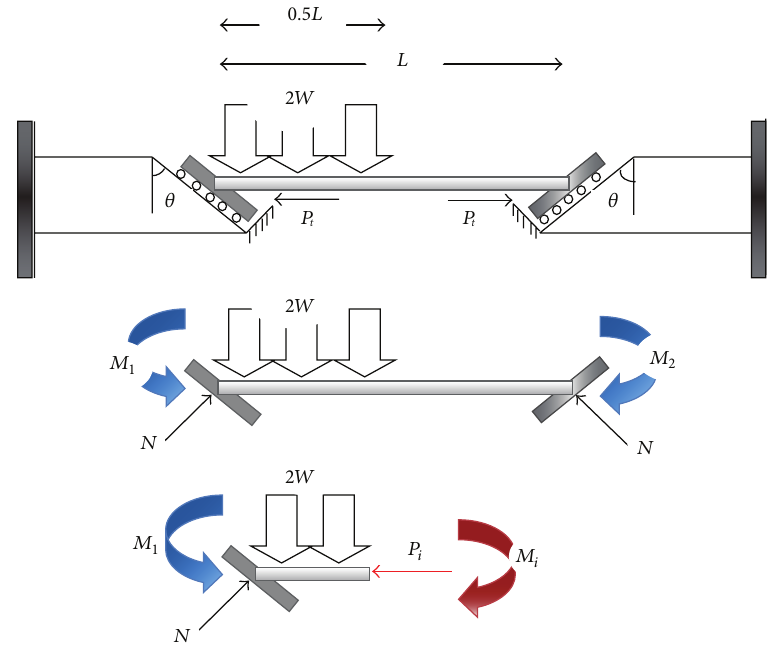
Figure 6: Simplification model of beam movement with nonsymmetric gravity load due to increase in temperature (frictionless support).